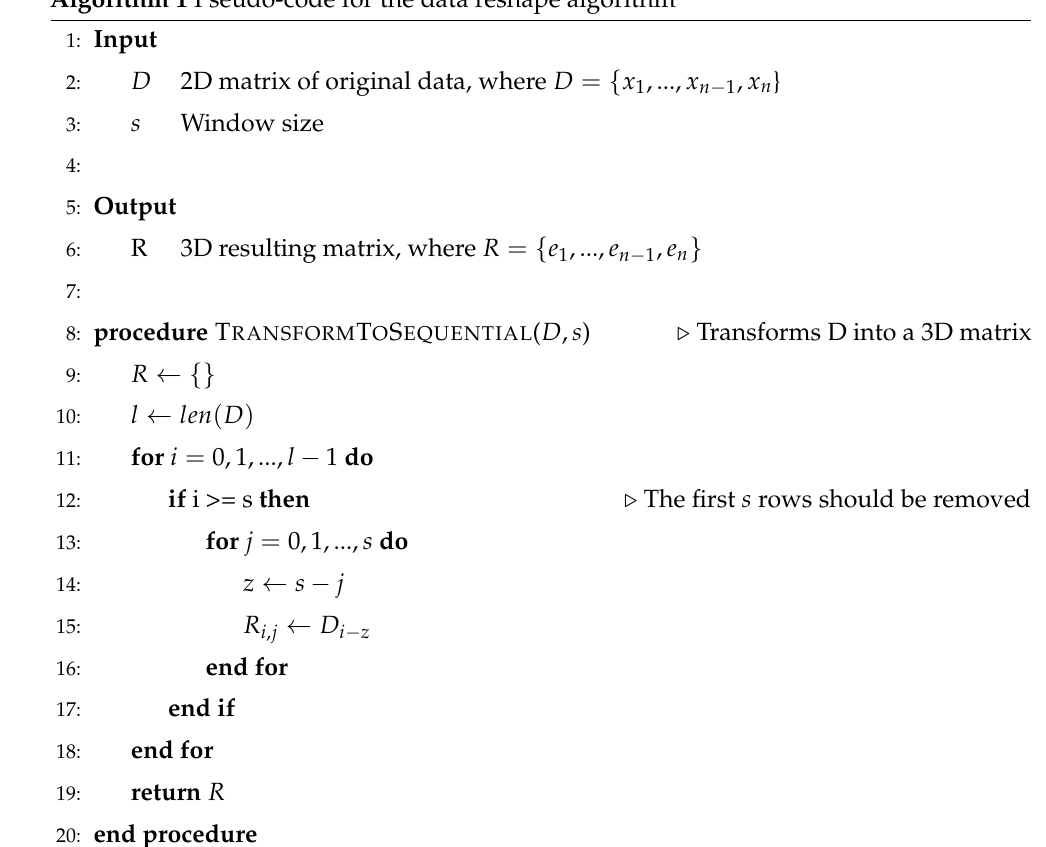
Algorithm 1 Pseudo-code for the data reshape algorithm